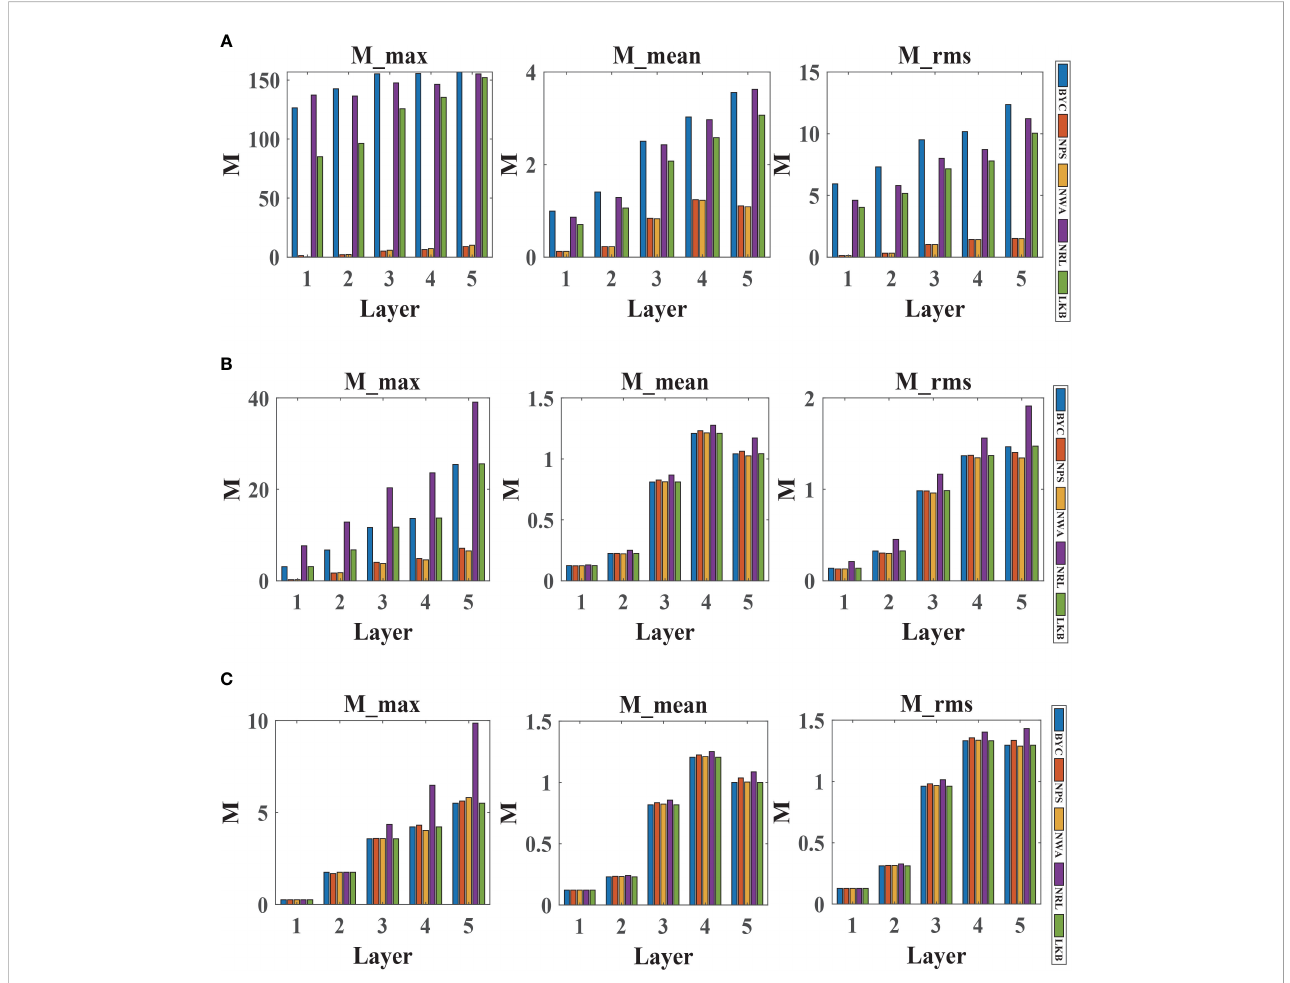
FIGURE 9 Model diagnosis results when the atmosphere is under stable conditions. (A) WS > 0 m/s. (B) WS ≥ 3 m/s. (C) WS ≥ 5